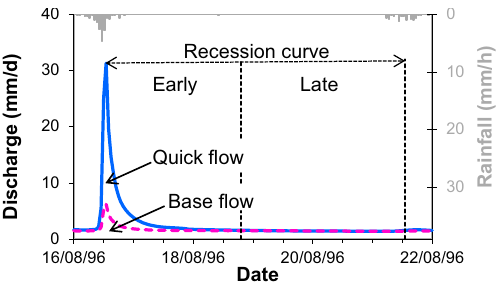
Figure 1. Quickflow and baseflow components of streamflow, and the early and late parts of the recession curve. Quickflow is repre- sented by the area between the streamflow and baseflow curves, and baseflow is the area under the baseflow curve.